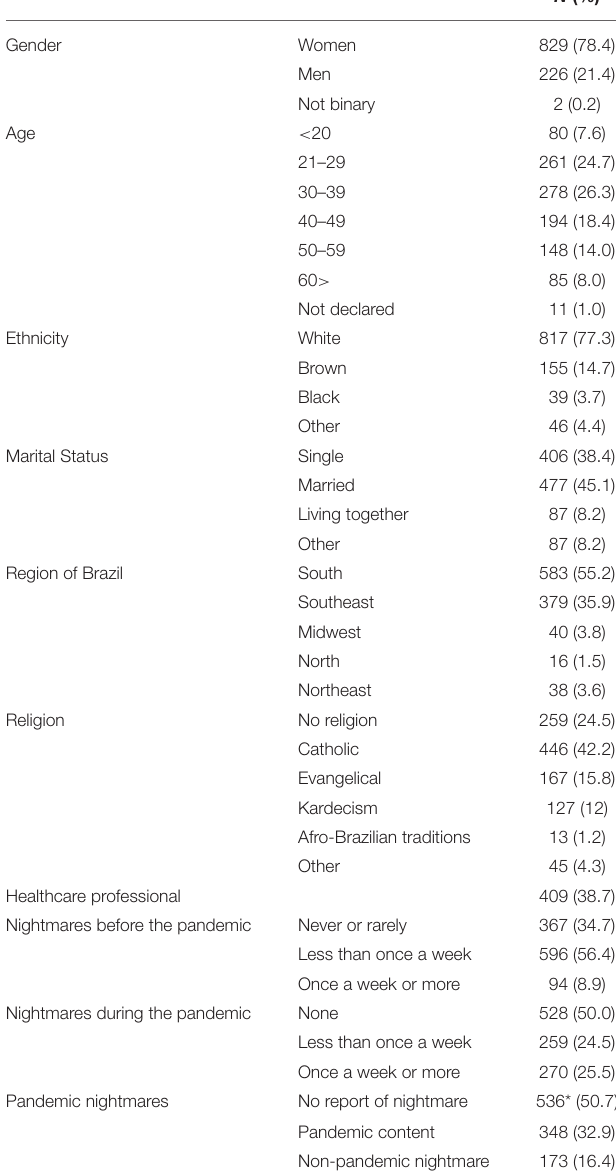
TABLE 1 | Sample’s characteristics ( N =